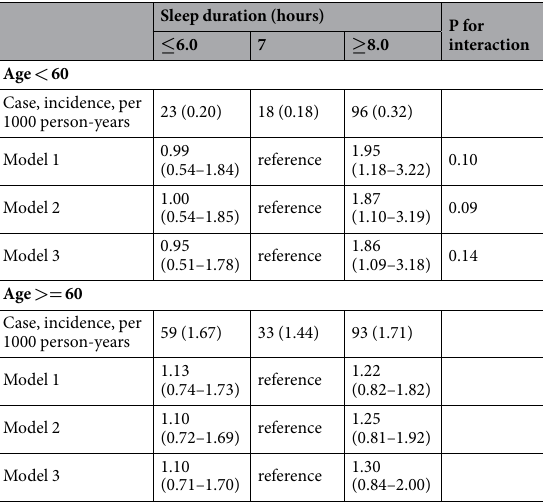
Sleep duration (hours)